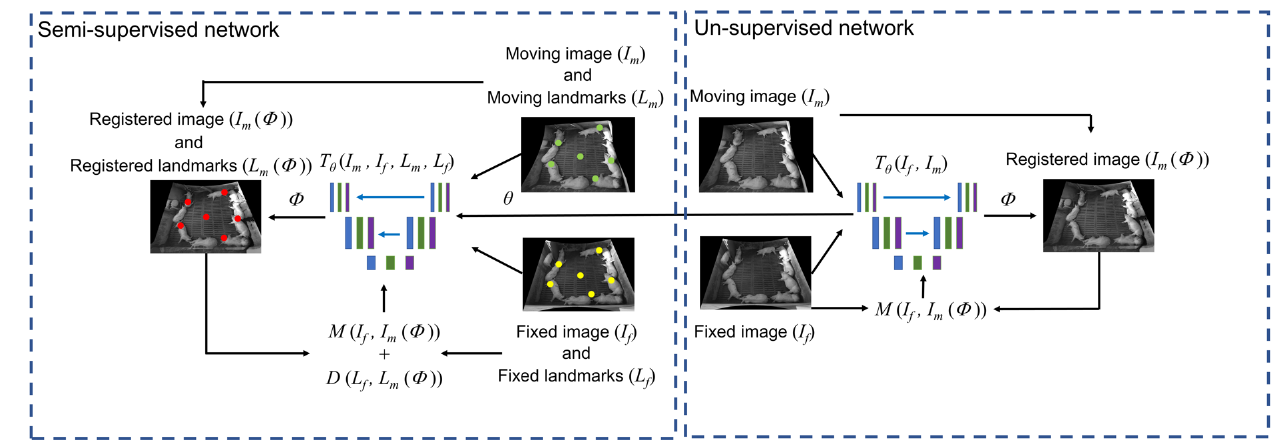
Figure 3. The proposed method consists of two stages. First, train the unsupervised network with image pairs without landmarks to obtain the weights across pig pens and over time; second, import these weights into the semi-supervised network and fine-tune with samples labelled with landmarks.